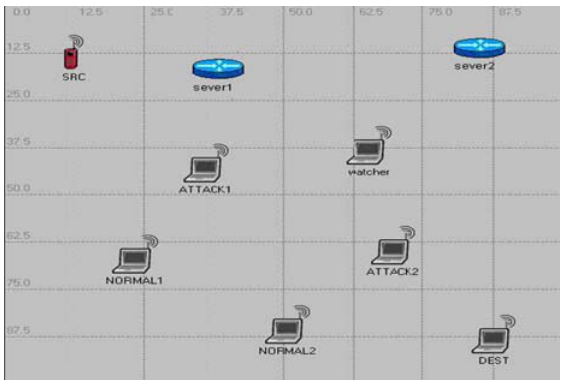
Fig.3. Simulation Scenario for the Received Packet Ratio